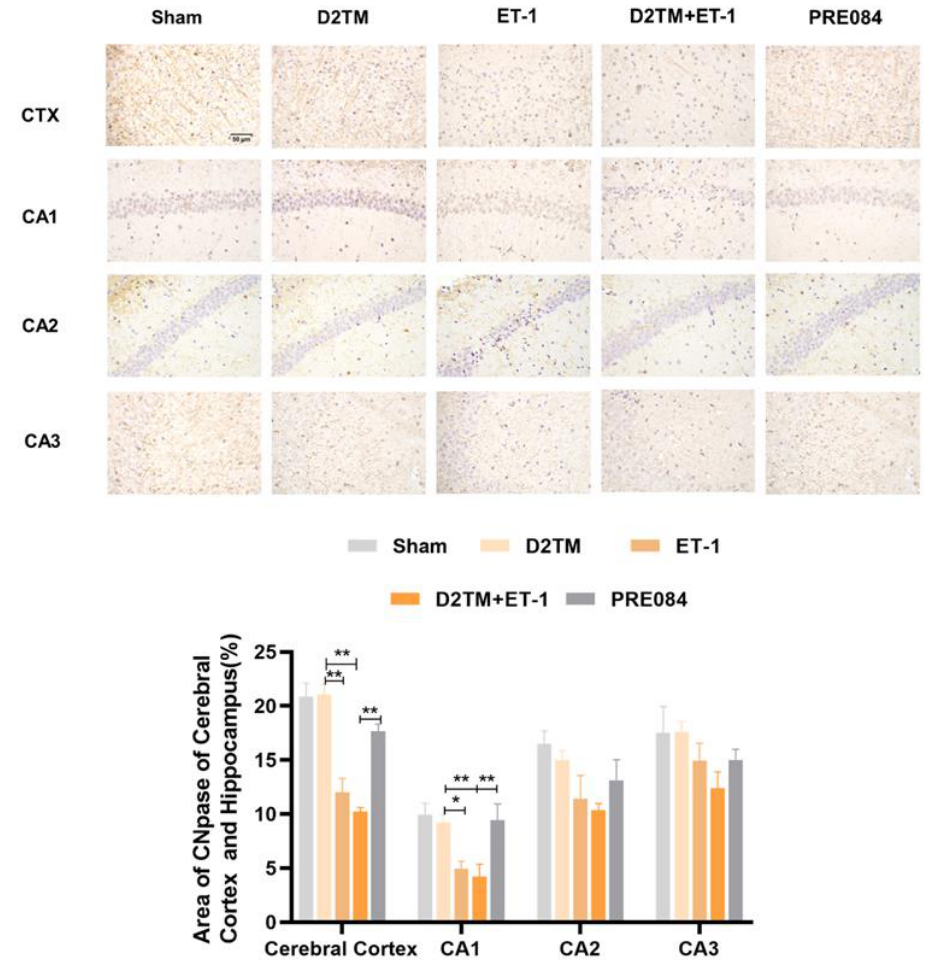
Figure 5. PRE084 increased the expression of CNpase in the cerebral cortex and in the hippocampal CA1, CA2, and CA3 regions of diabetic mice with stroke. Top: Representative images of CNpase 21 d after ET-1 injection. Bottom: Quantification of the area of the CNpase-immunostained cells in the cerebral cortex and in the hippocampal CA1, CA2, and CA3 regions. Data are expressed as mean ± SEM; n = 4–5/group. Scale bars = 50 µ m. * p < 0.05, ** p < 0.01, *** p < 0.001.